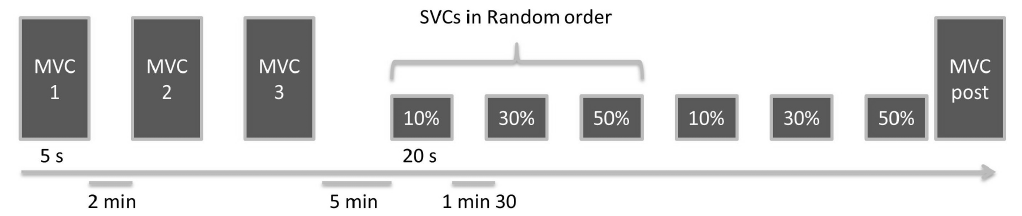
Figure 1. Experimental Design. MVC: Maximal Voluntary Contraction, SVC: Submaximal Voluntary Contraction.